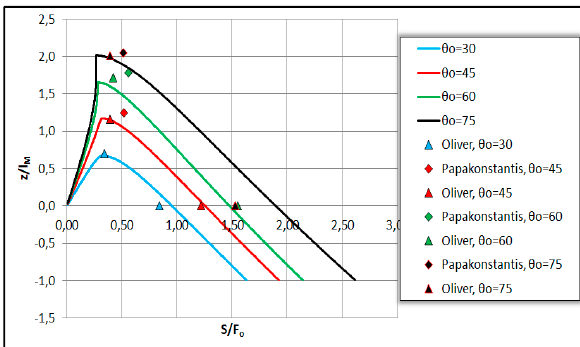
Figure 6. Comparison between model predictions and experiments regarding the axial dilution at the terminal height S m /F o and return point S r /F o of negatively buoyant saline